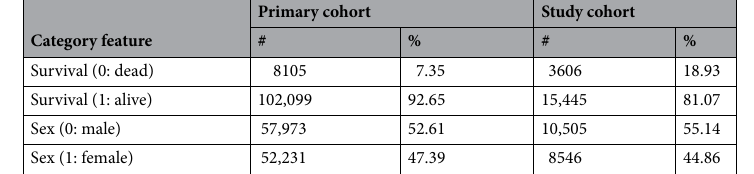
Category feature